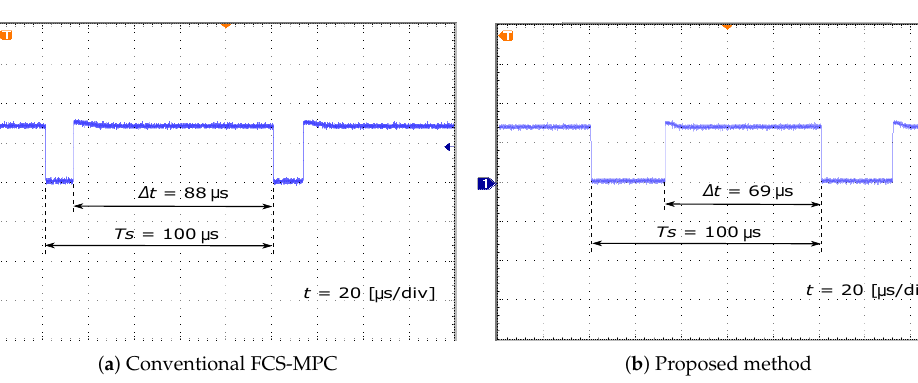
Figure 18. Execution time of the control strategy for the conventional FCS-MPC and proposed